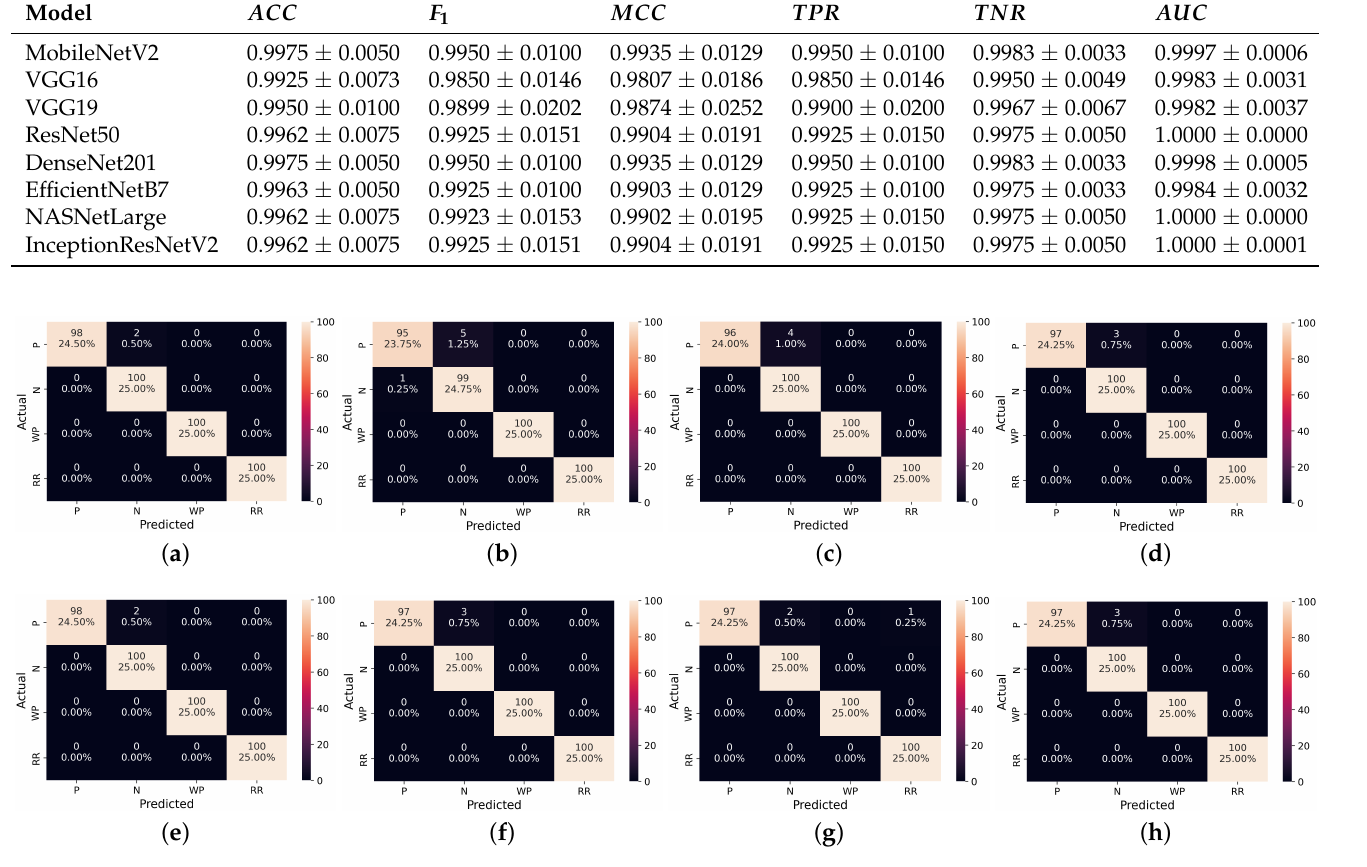
Table 2. Performance of the pre-trained models obtained from 5-fold cross-validation on the COVID- 19 PCR dataset.